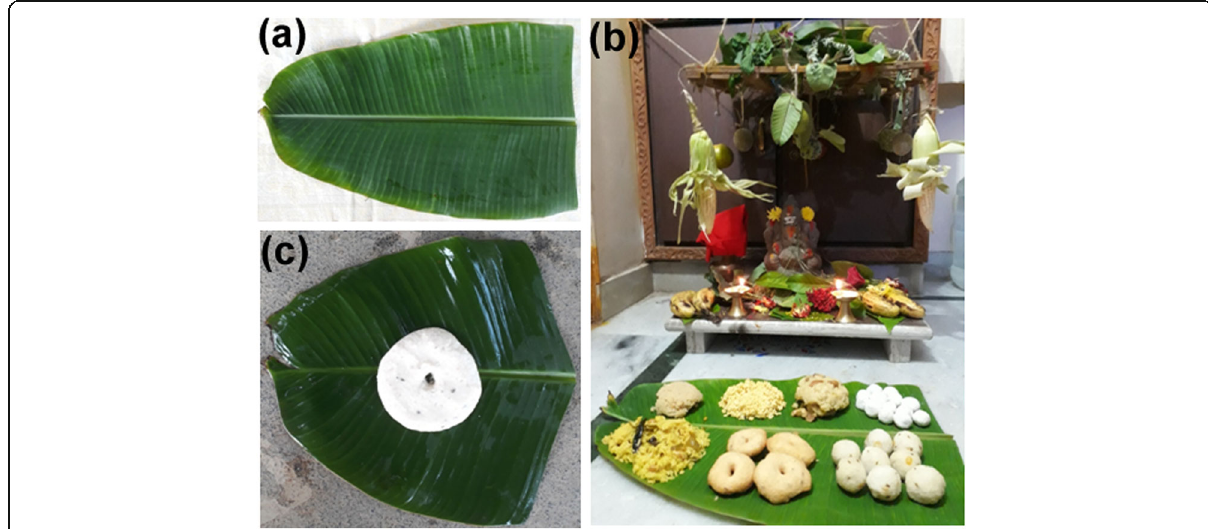
Fig. 3 a The leaf of banana, M. paradisiaca , ( b ) naivedyam offered to god Ganesha on banana leaf during the festival of Ganesh Chaturthi and ( c ) the utilization of banana leaf blade as a non-adherent surface for spreading the batter of gaare before oil